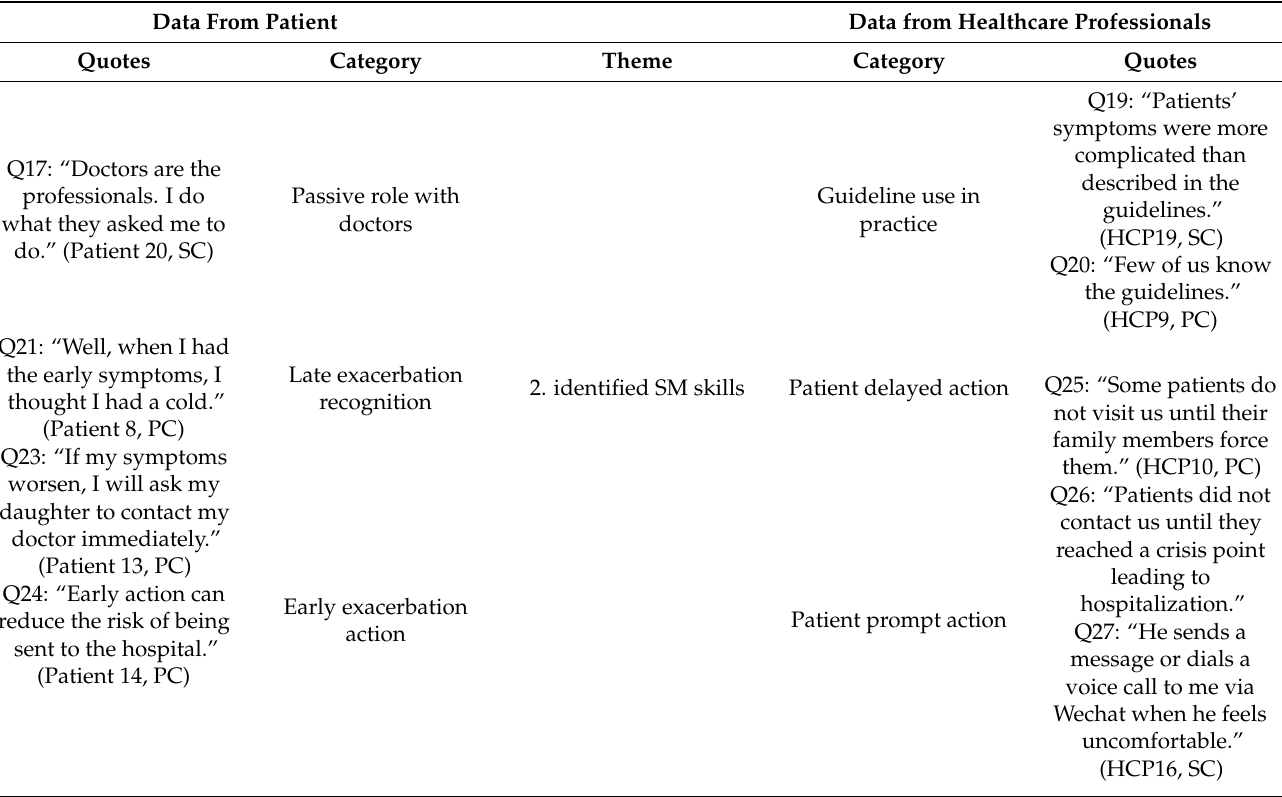
Figure 1. Identification of the chronic obstructive pulmonary disease (COPD) and asthma vignette from patients and healthcare professionals (HCPs).